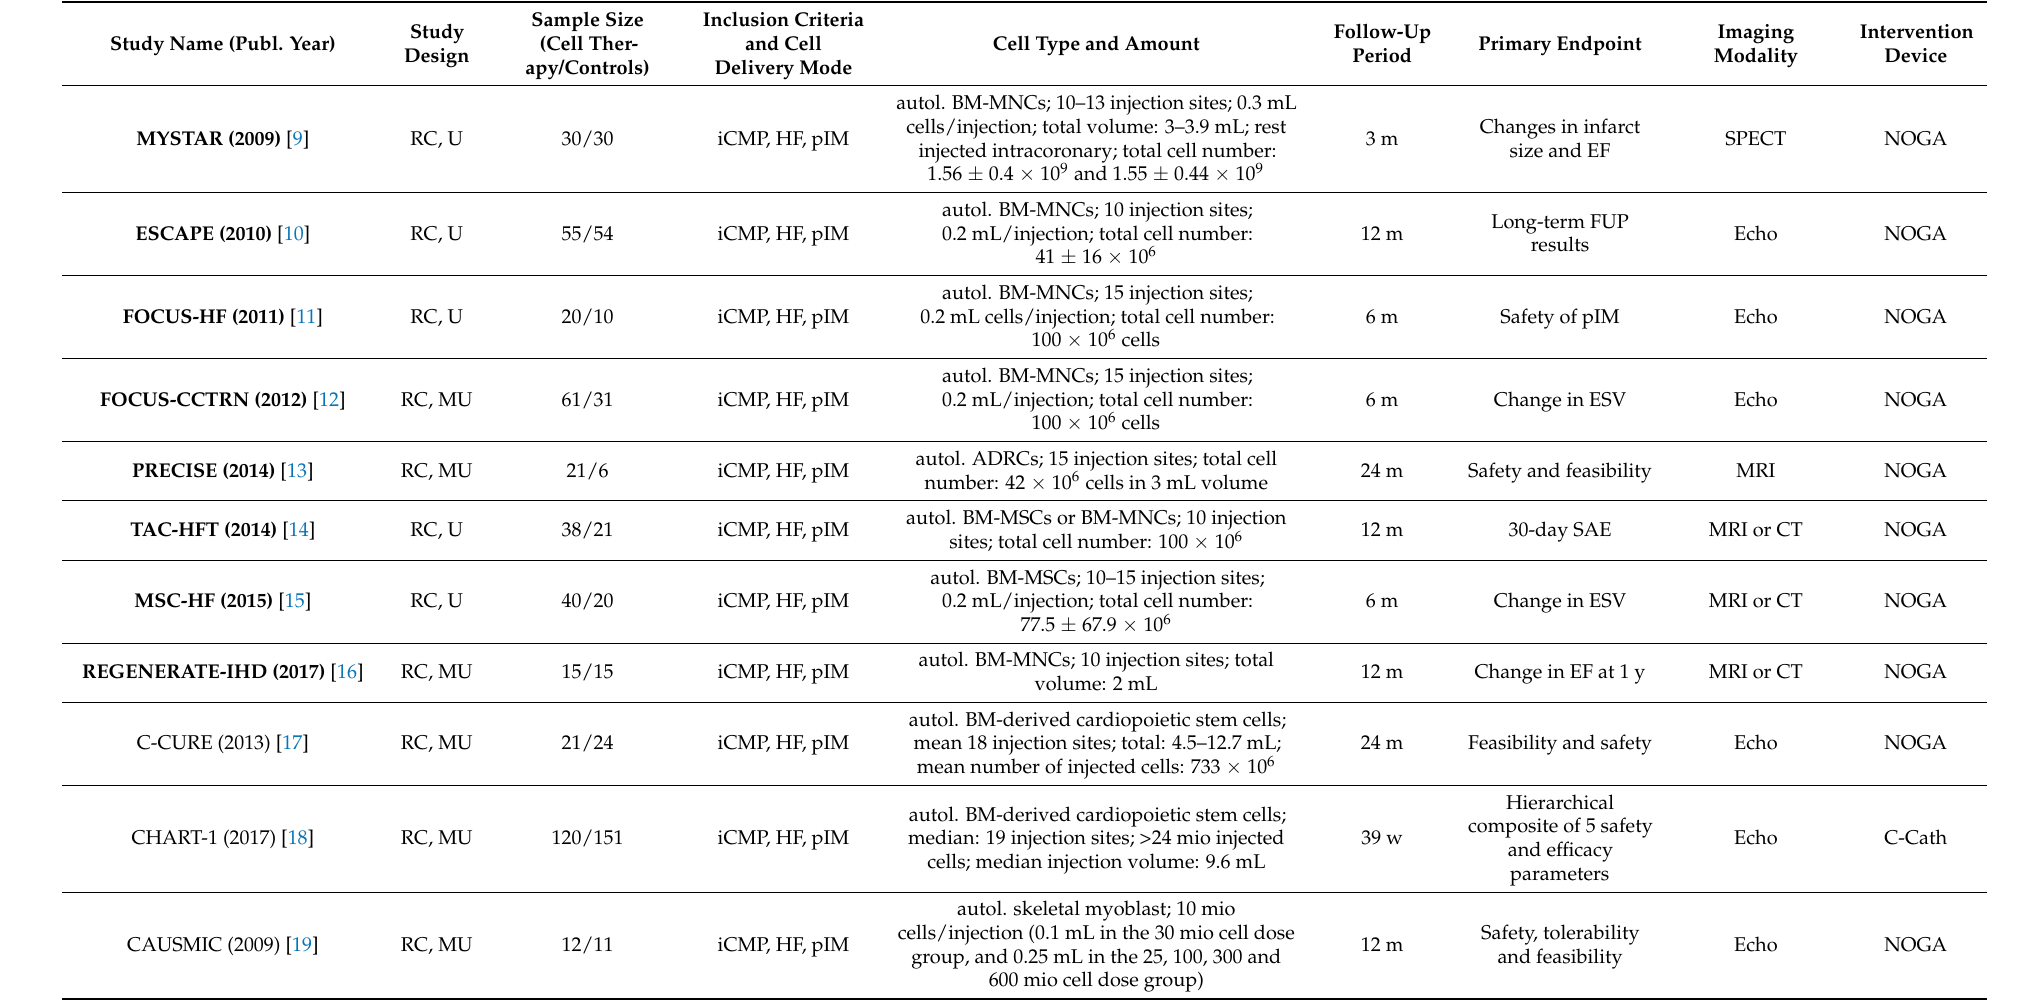
Table 1. Included